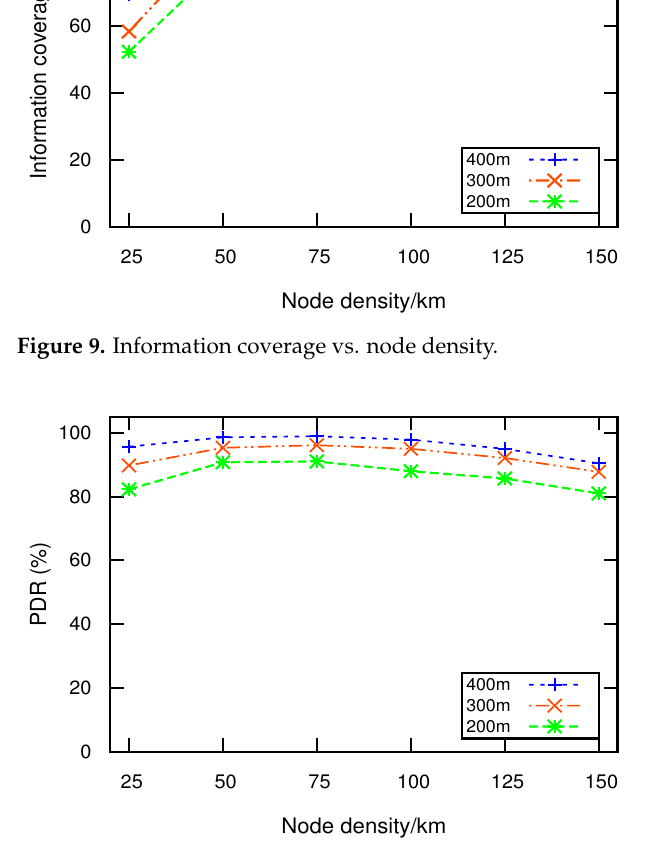
Figure 10. PDR vs. node